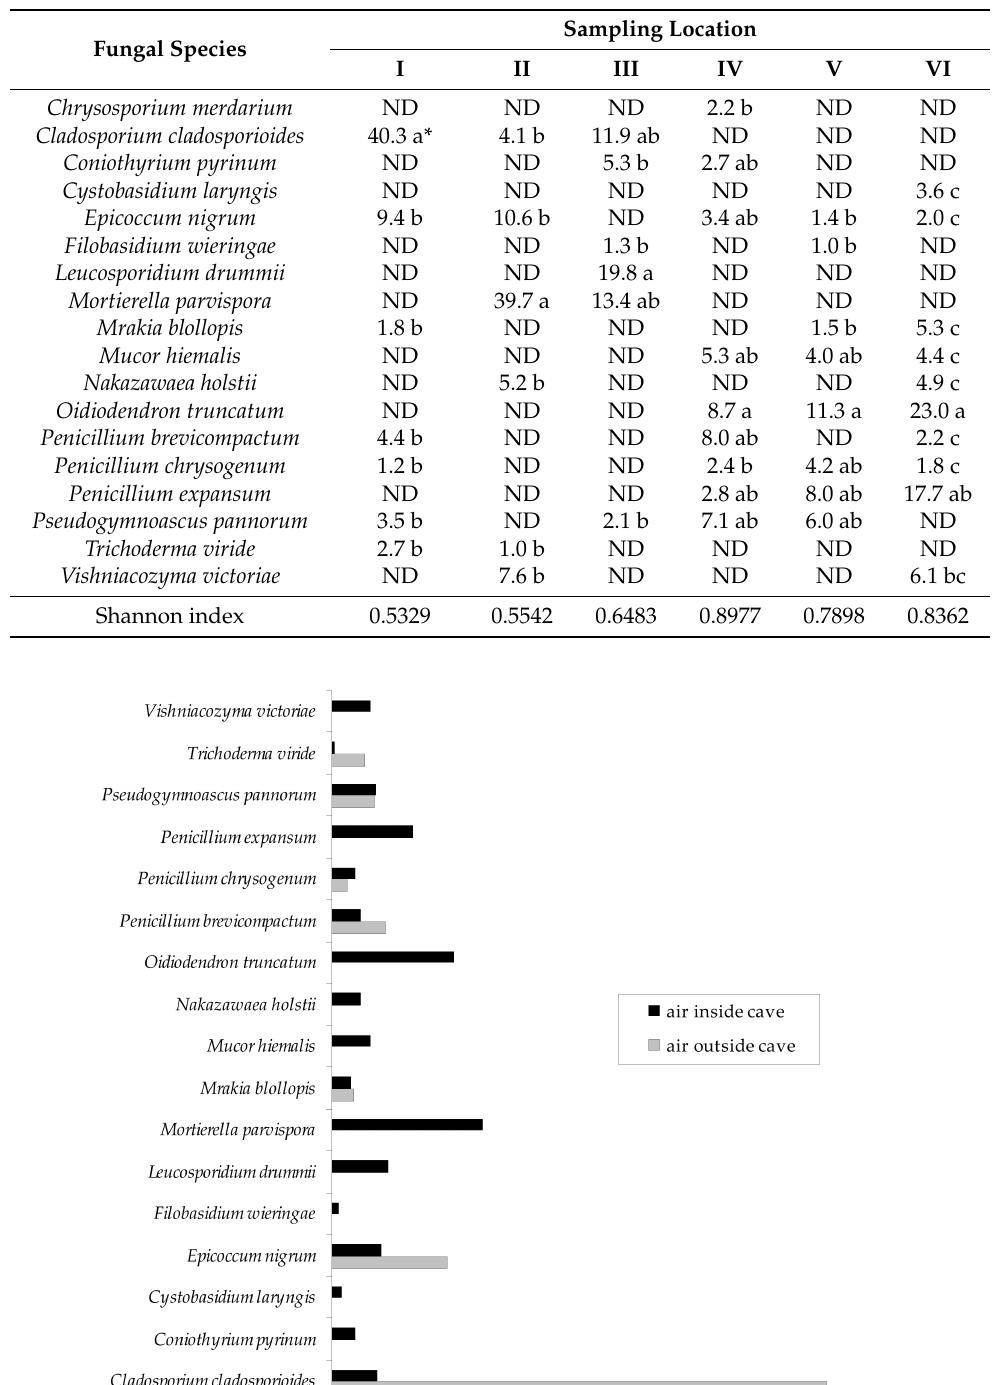
Table 1. Average number of airborne fungal propagules (CFU m − 3 ) in the Brestovsk á Cave: I—the outdoor air samples, II–VI—the indoor air samples; ND = not detected. * For each location, the number of fungal spores followed by the same letter are not statistically different, and others are (Tukey HSD test, α ≤ 0.05). Letters indicate the differences between fungal species in a given location.